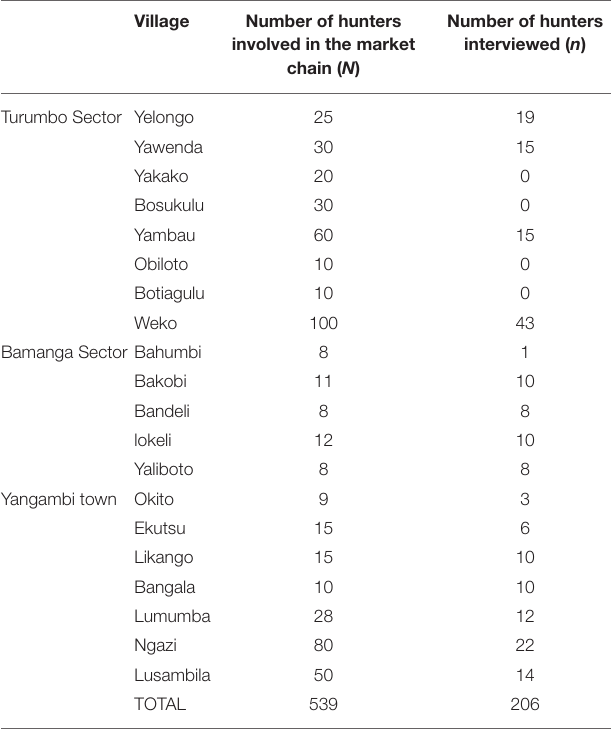
TABLE 2 | Number of active hunters per village/neighborhood and number of hunters sampled in this study. Number of hunters Village Number of hunters interviewed ( n ) involved in the market chain ( N ) Turumbo Sector Yelongo 25